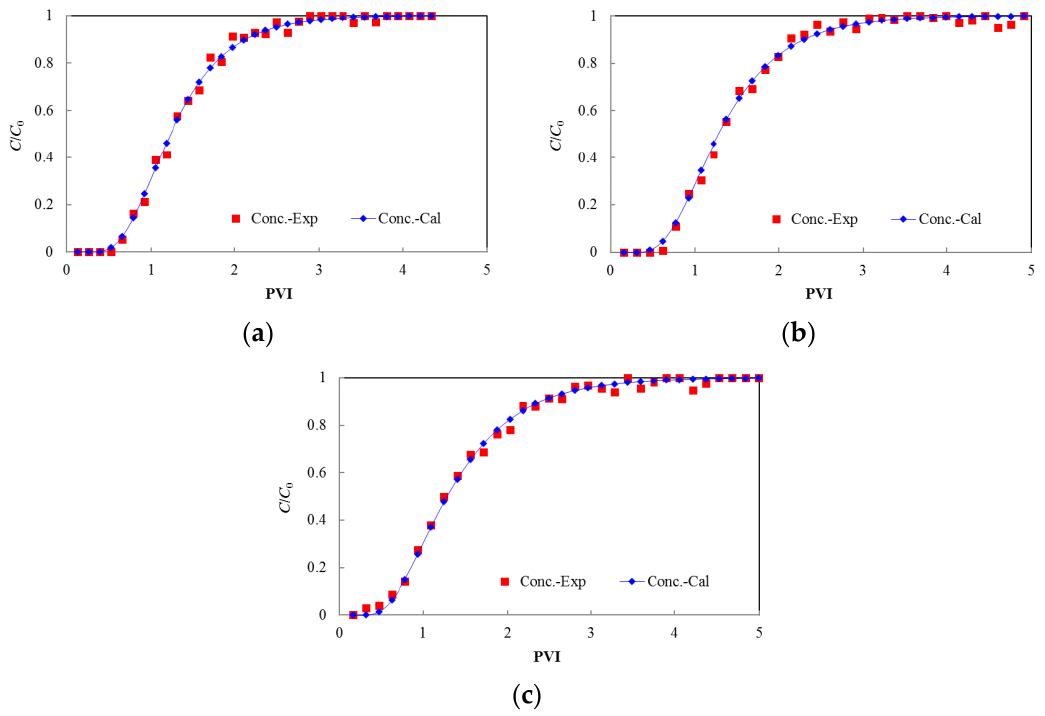
Figure 5. Data fitting for tracer concentration ratio versus pore volume injected (PVI) at high flow rate (0.04 cm 3 /s) in natural cores: ( a ) core No. 1 (1570 mD), ( b ) core No. 2 (610 mD), and ( c ) core No. 3 (230 mD).